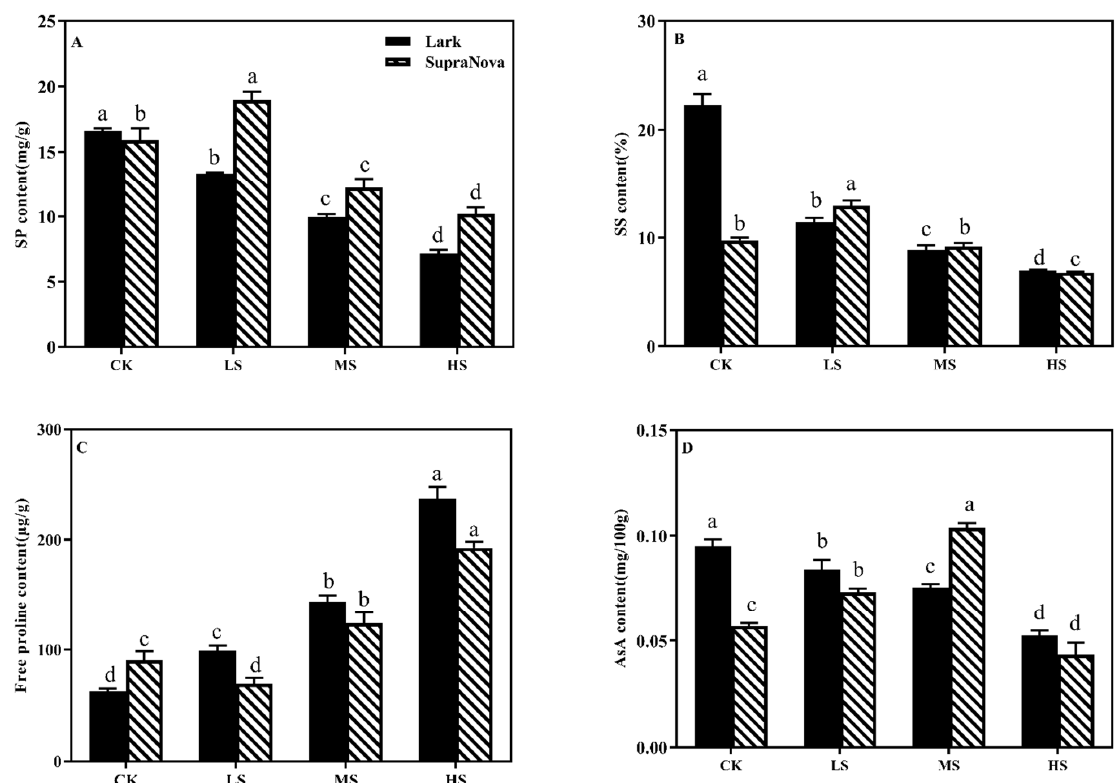
Figure 4. SP, SS, Pro, and AsA contents of two species under different shade treatments ( A – D ). The lowercase letters denote significant differences ( p < 0.05) for the same species. CK = unshaded; LS = 35% shaded; MS = 70% shaded; HS = 92% shaded. The black box represents the species ‘Lark’ and the striped box represents the species ‘SupraNova’.